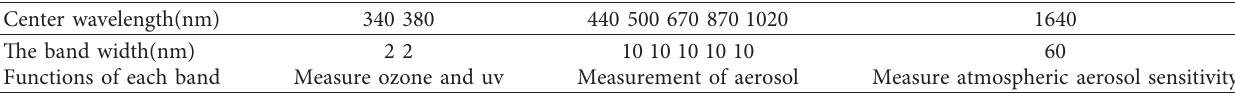
Table 1: The functions of various bands of